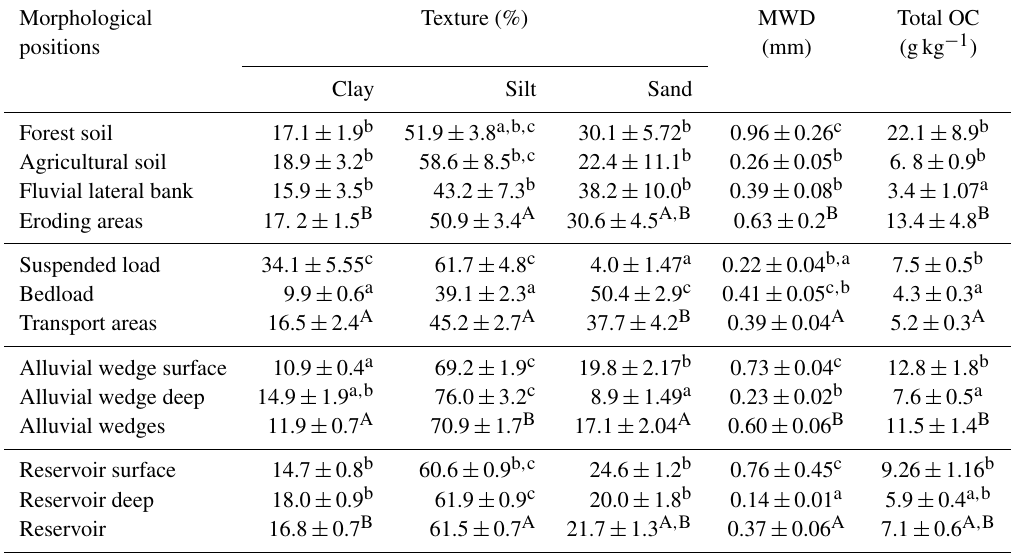
Table 2. Soil texture, MWD, and total organic carbon (OC) in different morphological positions across the catchment: eroding, transport, and depositional